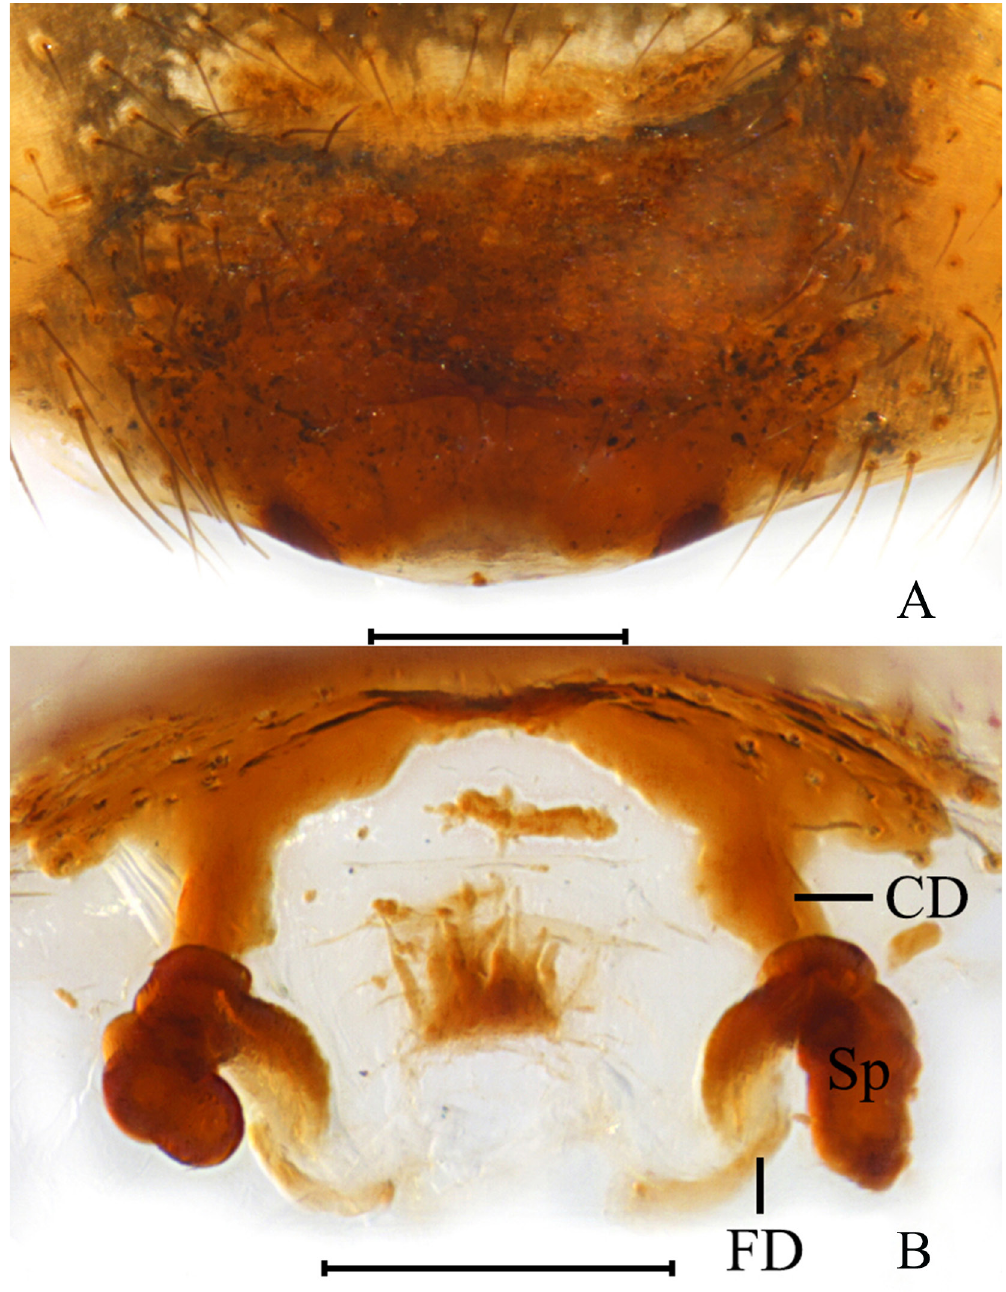
Fig. 14. Meta yinae sp. nov. Paratype ♀ (HNU-Tang-05-08). A . Epigyne, ventral view. B . Vulva, front view. Scale bars: 0.2